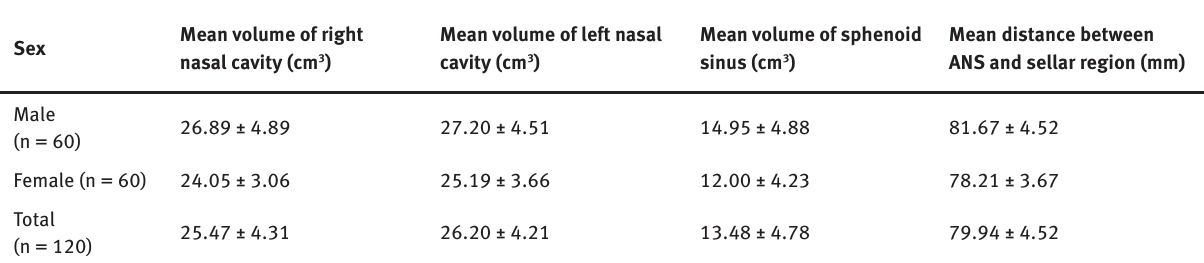
Variable r p Distances between the anterior nasal spine and sellar region and volumes of the right nasal